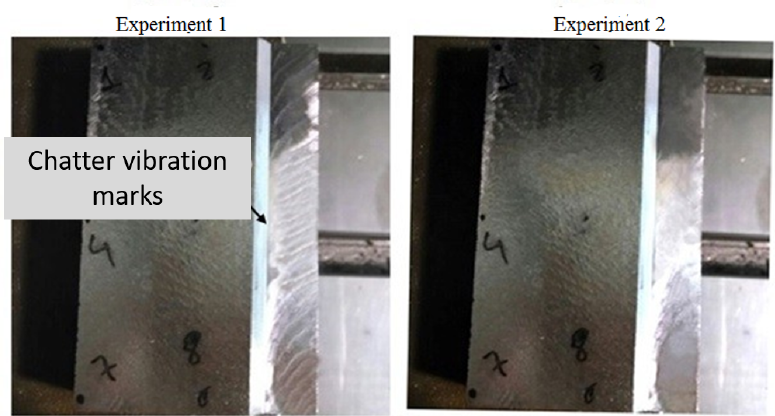
Fig. 7. Workpiece after milling of gray cast